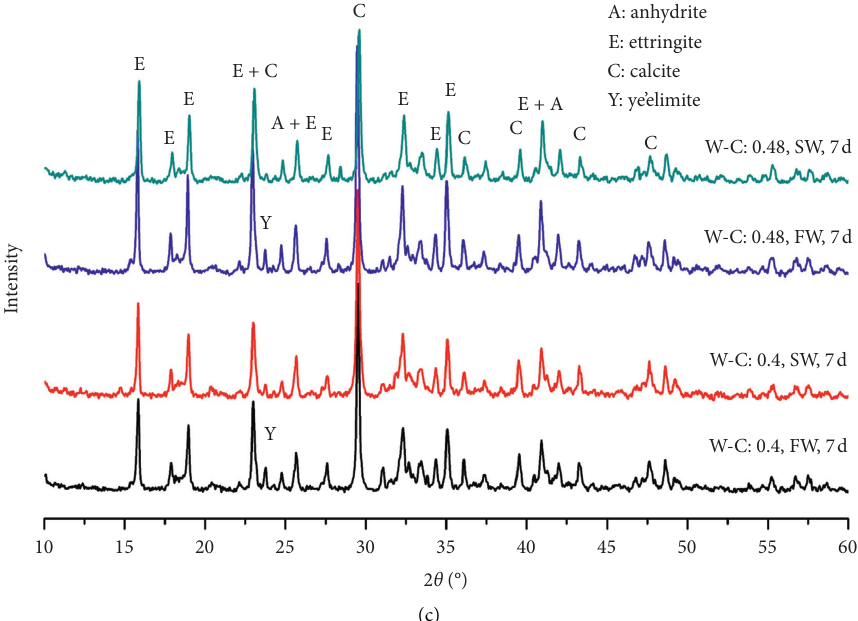
Figure 4: XRD patterns of CSA cement with different types of mixing water and w/c ratios. (a) CSA cement paste with different mixing water cured for 30 min and 1h. (b) CSA pastes cured for 1d. (c) CSA pastes cured for